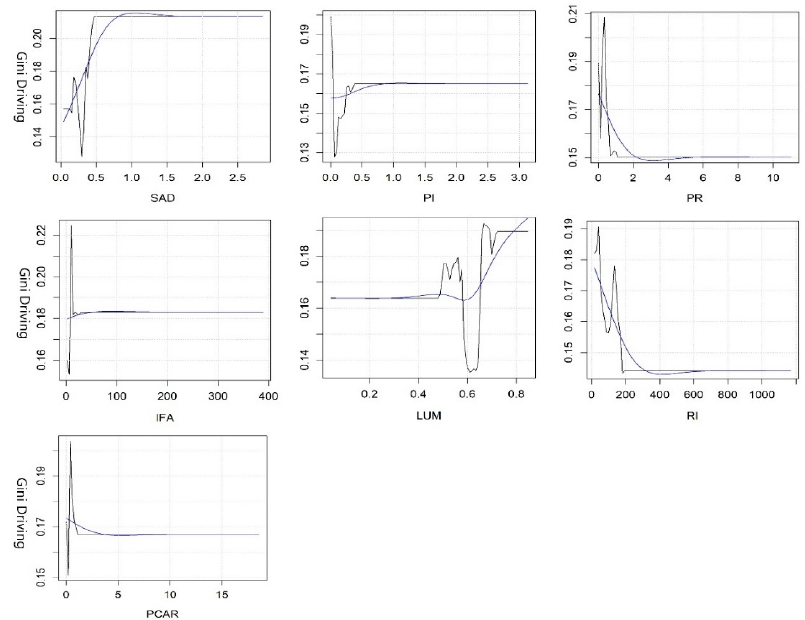
Figure 7. Nonlinear effects of various variables on the equity of PGSs by driving.